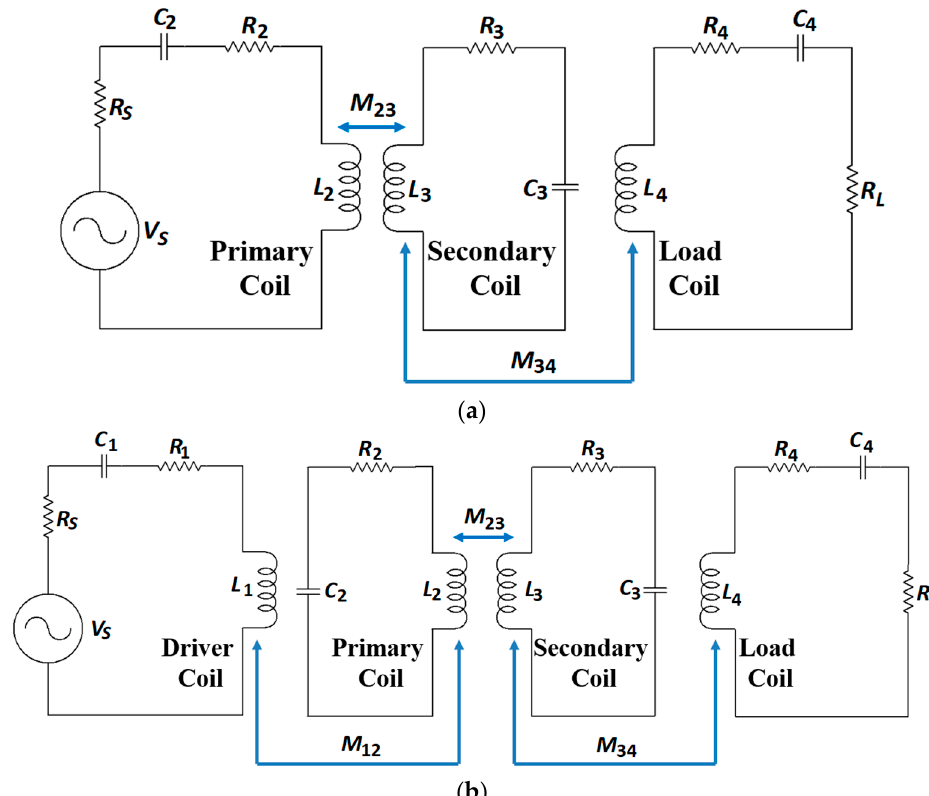
Figure 23. Non-radiative magnetic resonance coupling (NRMRC) equivalent circuit. ( a ) Three-coil technique. ( b ) Four-coil technique. technique. ( b ) Four-coil